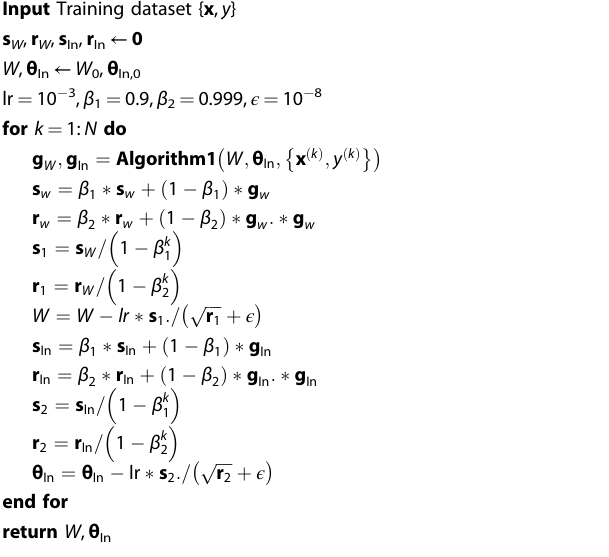
Algorithm 2 . Adam optimizer